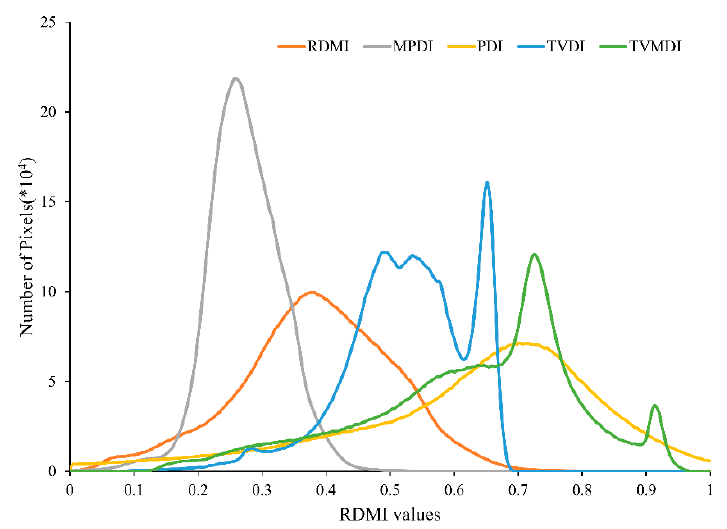
Figure 13. A comparison of the frequency distributions of the RDMI, MPDI, PDI, TVDI, and the TVMDI dryness maps.